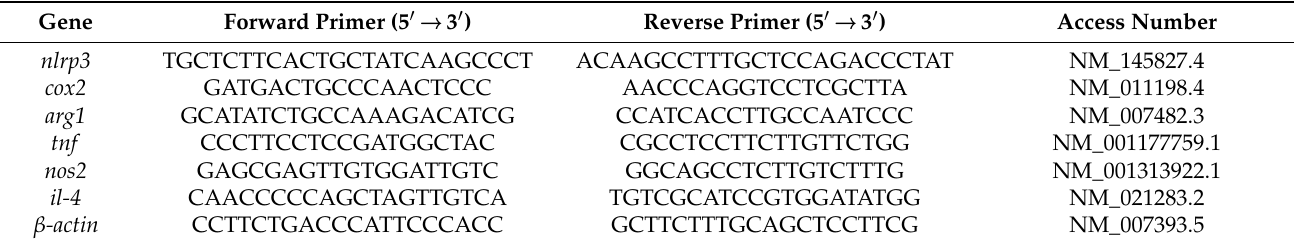
Table 1. Primer sequences of gene of